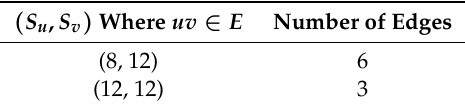
Table 8. Edge partition of G n ( n = 2 ) on the basis of degree sum of neighbors of end vertices of each